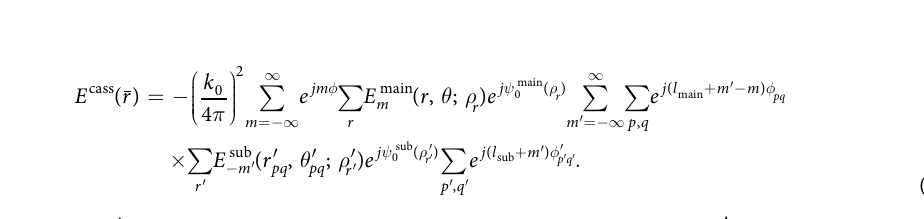
Figure 3. Near-field magnitude and phase patterns of the Cassegrain dual-reflectarray antennas in Fig. 1 simulated and measured using f = 18 [GHz], z = 124 [mm], and l main = + 1. The main reflectarray is placed at z = 0. (a,e,i) Simulated magnitude patterns for = + − l 1, 0, 1 , respectively. (b,f,j) Measured magnitude sub , respectively. (c,g,k) Simulated phase patterns for = + − l 1, 0, 1 , respectively. patterns for = + − l 1, 0, 1 sub sub , (d,h,l) Measured phase patterns for = + − l 1, 0, 1 sub